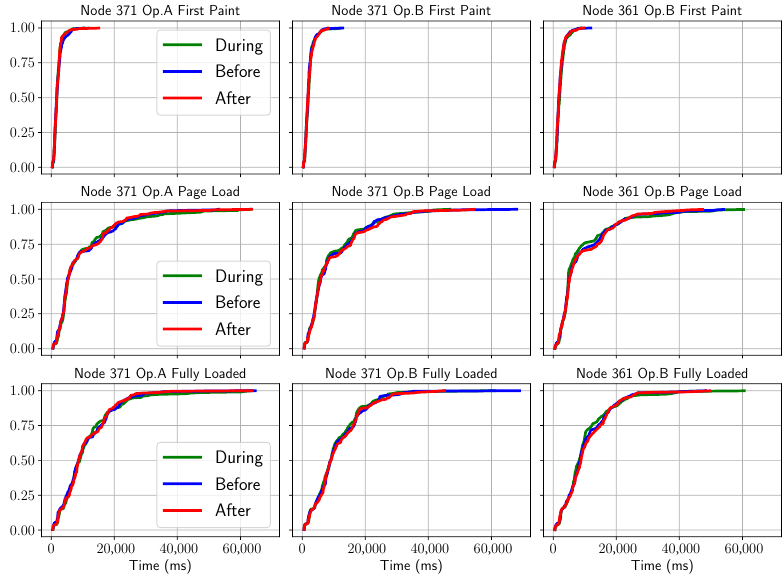
Figure 6. CDF of HTTP KQI behavior before/during/after the match.